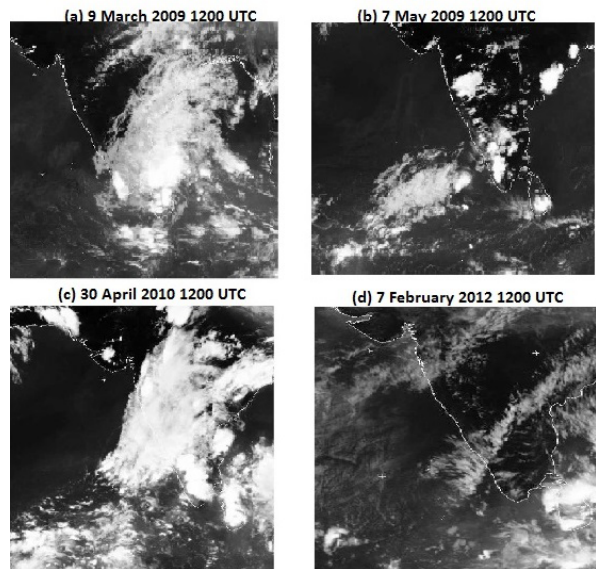
Figure 10. METEOSAT IR image on 9 March 2009, 7 May 2009, 30 April 2010 and 7 February 2012 at 12:00UTC.